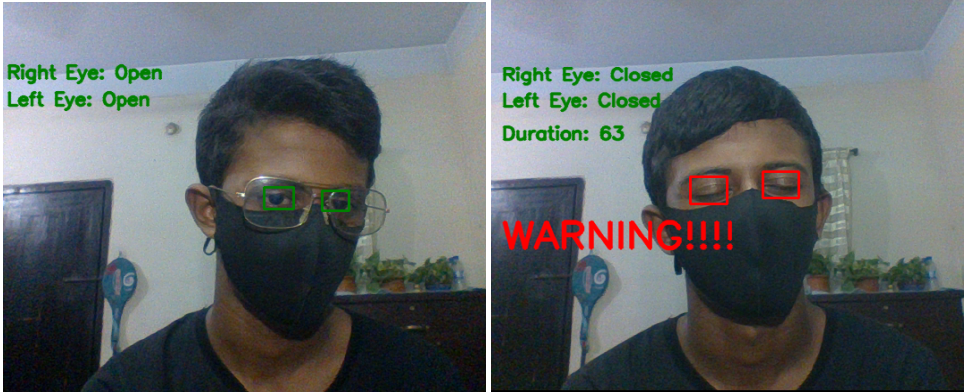
Figure 15. Real-time implementation of drowsiness detection (with and without